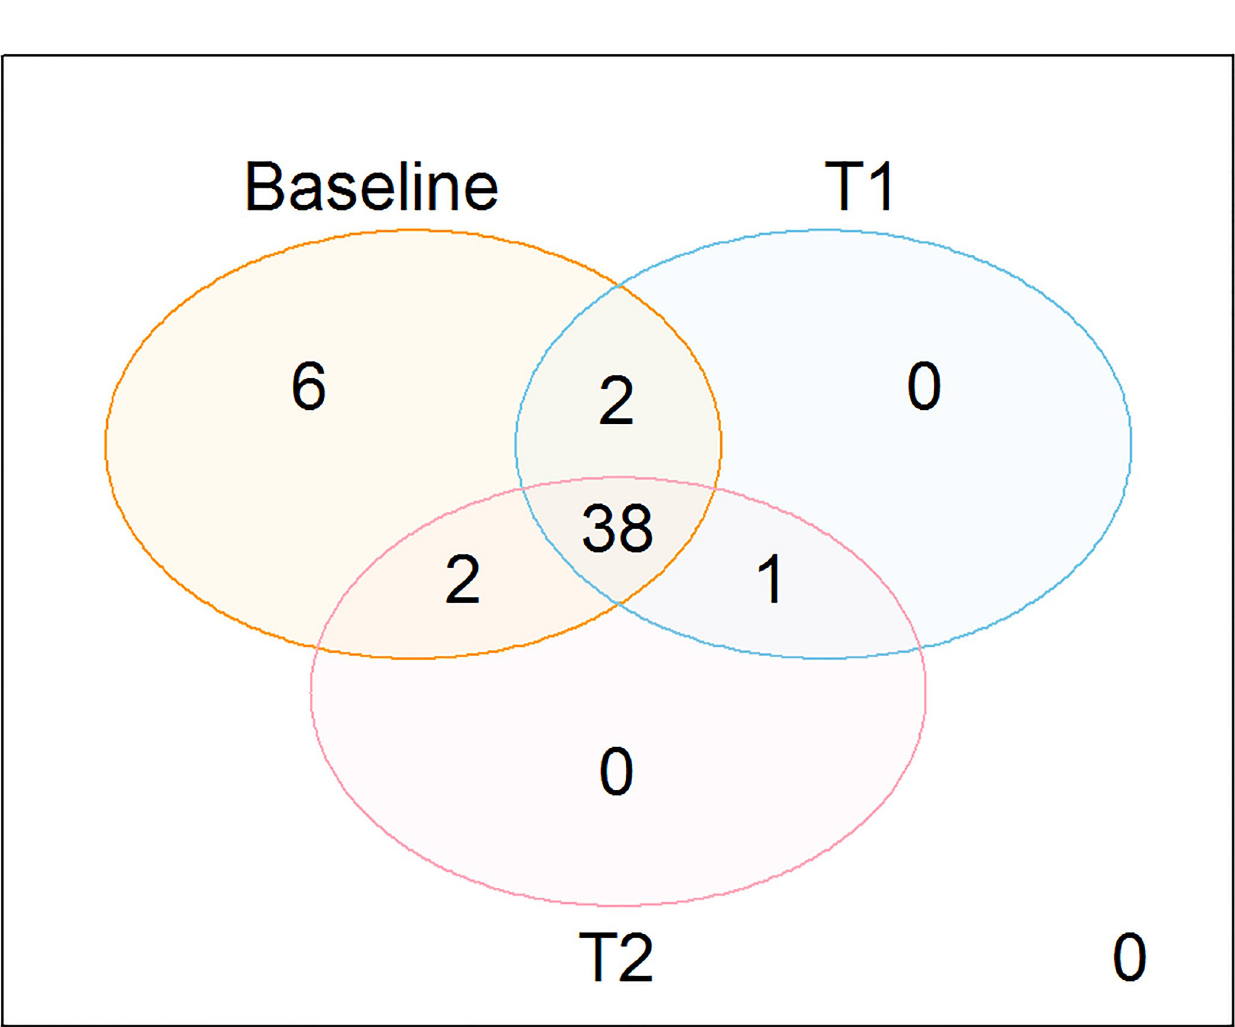
Fig 1. Overlaps between the number of mice at baseline, T1, and